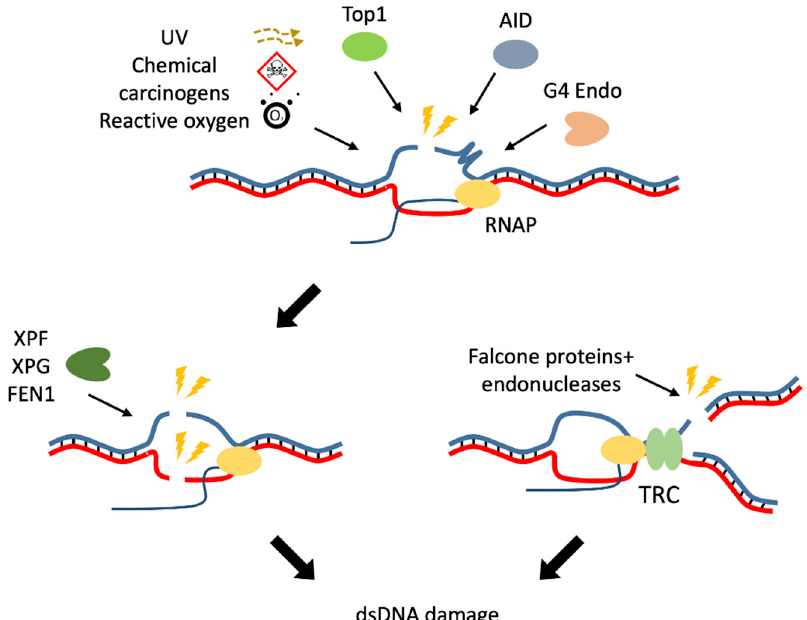
Figure 1. Origin of double-strand breaks under the influence of R-loops. The causes of single- strand breaks (in the upper part of the figure) may be exogenous, such as ultraviolet radiation (UV), chemical carcinogens, reactive oxygen, or might be endogenous, such as the activity of topoisomerase I (Top1), activation-induced cytidine deaminase (AID) or G4-specific endonucleases (G4 Endo). Another single-strand break can occur in the same region of DNA due to endonucleases xeroderma pigmentosum group G and F (XPG and XPF) or flap endonuclease 1 (FEN1), leading to double-strand DNA damage (dsDNA damage). Transcription–replication conflict (TRC) may also cause dsDNA damage (in the lower right part of the figure).